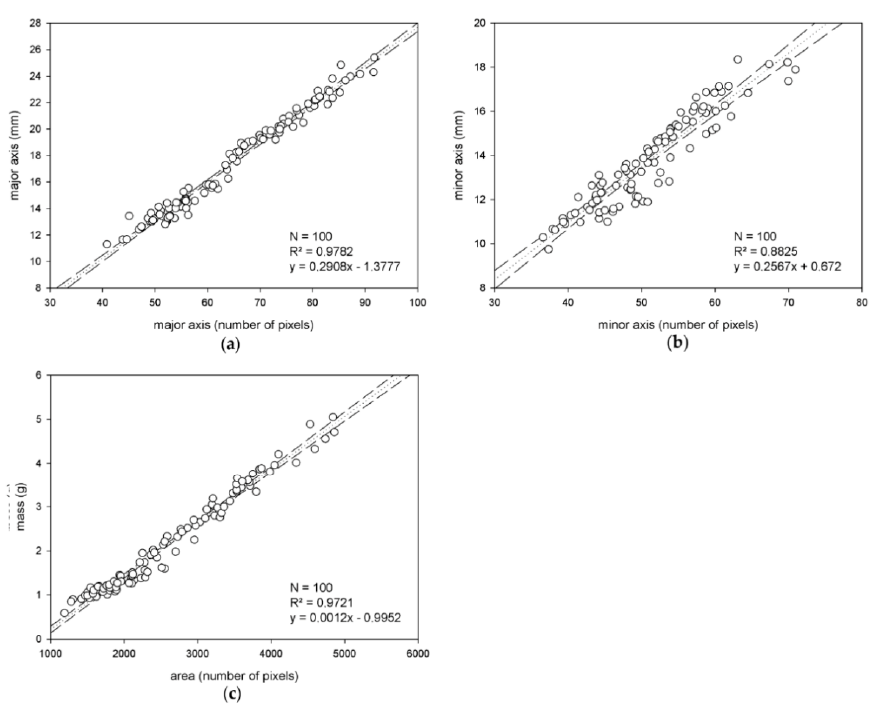
Figure 7. Correlation study of variety-independent model trained on the instances from both Arbequina and Picual varieties, considering the three different targeted features: The major axis ( a ), minor axis ( b ) and mass ( c ). Table 2. Estimation results, calculated on the external validation sets, for the three studied features detailed per variety and modeling approach. Outcomes are expressed in terms of Root-Mean-Square Error (RMSE; Equation (12)), Relative Root-Mean-Square Error (SE; Equation (13)), and Relative Mean Error ( |𝐸| ; Equation (14)).